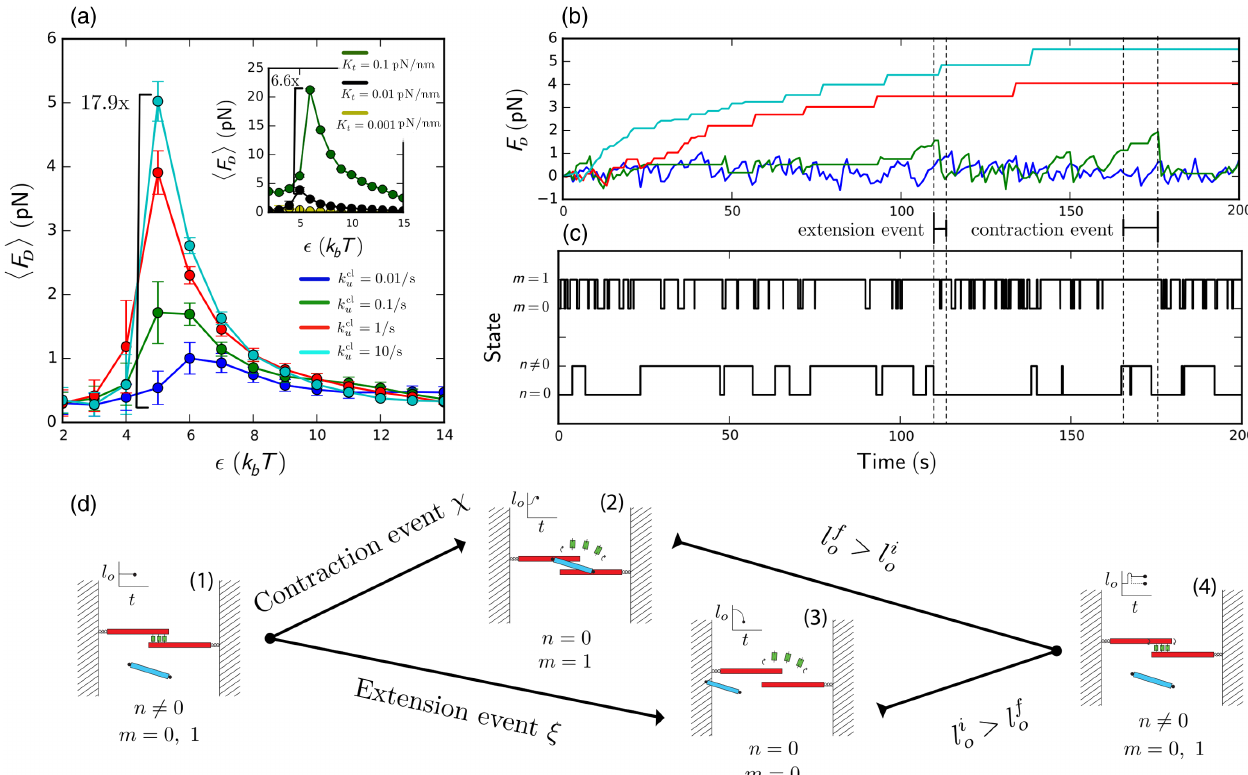
FIG. 5. Actomyosin ratcheting due to transient cross-linking in the one-dimensional active force dipole. (a) Variation of average dipole i produced on τ ¼ 200 s shows similar biphasic behavior compared to a PFD, but is amplified greatly due to the presence of force h F D lab the stochastic motor against a 0 . 01 pN = nm tether. Amplifications from the transient motor force are shown ( ≈ 0 . 3 pN). Inset shows the ¼ 1 = s. The catch-bond nature of myosin II is apparent in the overall effect of varying external stiffness of the diplole K for a fixed k cl u t T shows a steplike approach to increase in generated force at high stiffness. (b) Stochastic force production of the dipole at ϵ ¼ 5 k b steady state. Increasing kinetic rates maximize overlap generated on τ . (c) The corresponding state trajectory of the same force dipole lab ¼ 0 . 1 = s, which correspond to contraction and extension events in (b). m ¼ 0 , 1 represents the unbound and bound states of the with k cl u motor, respectively. n ¼ 0 and n ≠ 0 represent the cross-linker state. (d) The proposed ratcheting process in an active force dipole. (1) The process starts at a stable configuration n ≠ 0 . The motor can be either bound or unbound ( m ¼ 0 or þ 1 ). (2) Cross-linkers then unbind from the dipole ( n ¼ 0 ). If m ¼ þ 1 , a contraction event occurs, contracting the filaments to a new overlap l f o > l i . (3) If m ¼ 0 , o . (4) Cross-linkers rebind ( n ≠ 0 ), stabilizing the l f o an extension event occurs in which the filaments lose overlap such that l f o < l i o achieved in (1) – (3) in a contracted or extended configuration. This process repeats as pairwise overlap is created between the antiparallel pair, generating contractile